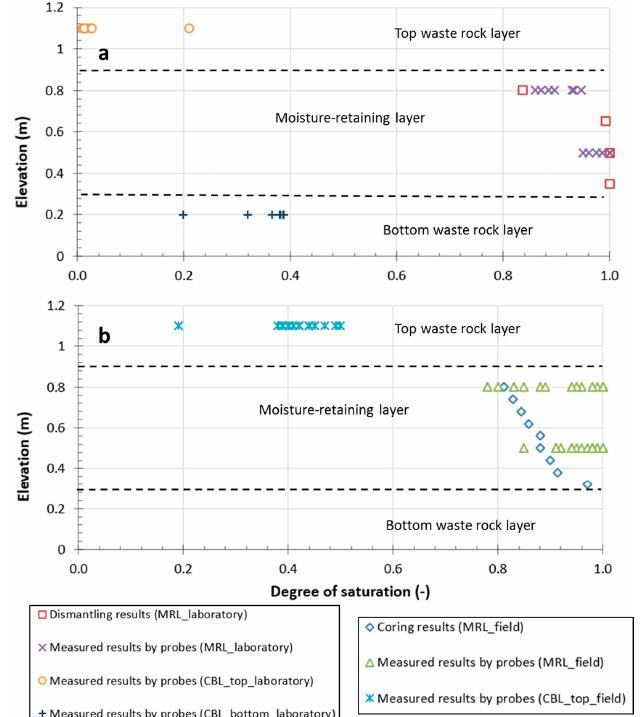
Figure 7. Degree of saturation measured in the moisture-retaining layer (MRL) and capillary break layer (CBL) and post-testing measurements: ( a ) Laboratory column and ( b ) field cell.